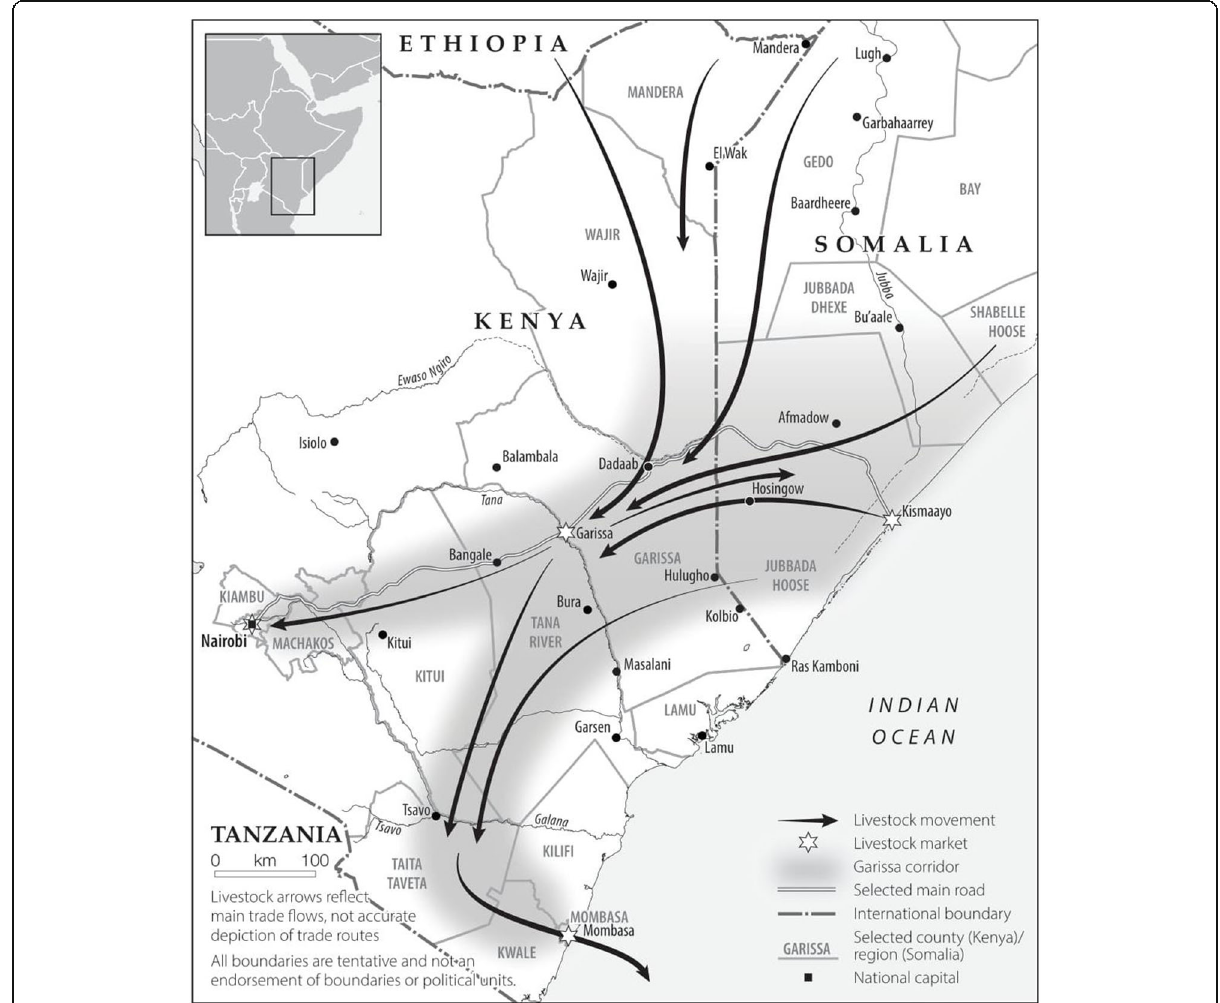
Fig. 1 Livestock trading and flows in the Somali-Kenya trade corridor, Source; Ng'asike et al. 2020